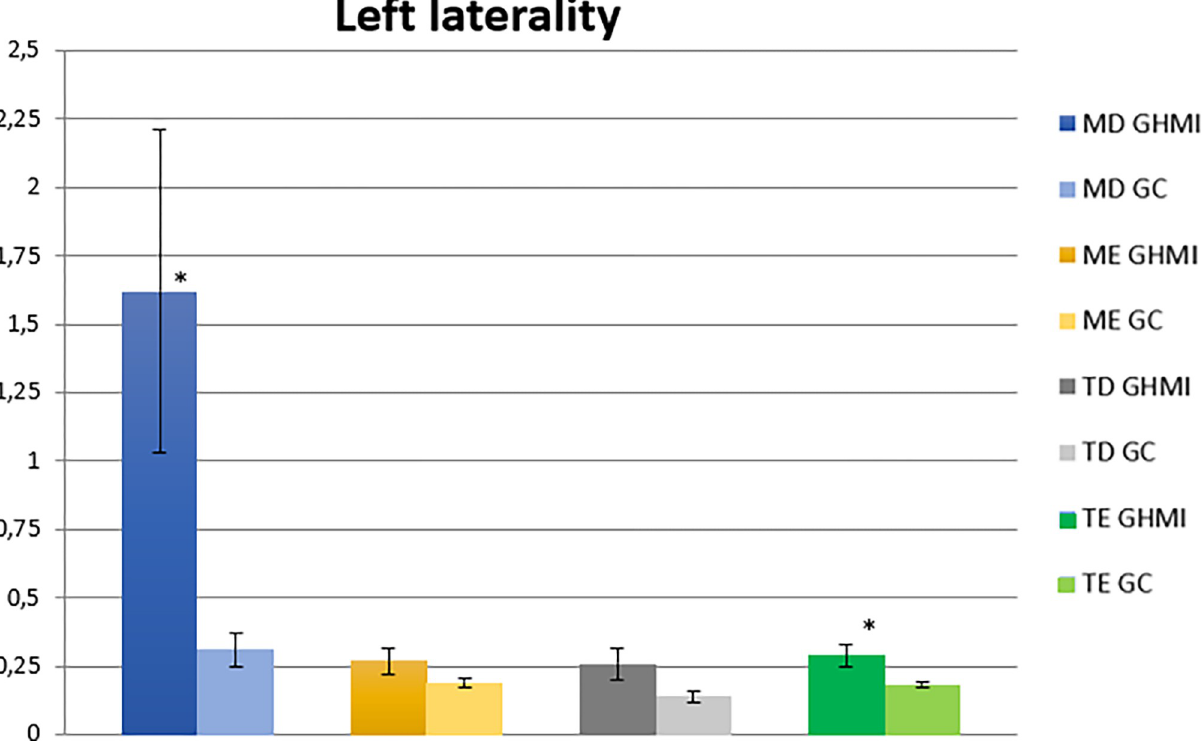
Fig 5. Normalized electromyographic means (RMS) in the right laterality condition for the right masseter (RM), left masseter (LM), right temporal (RT) and left temporal (LT) muscles, in the MIH (MIHG) and control (CG) groups. MIH, Molar-incisor hypomineralization.